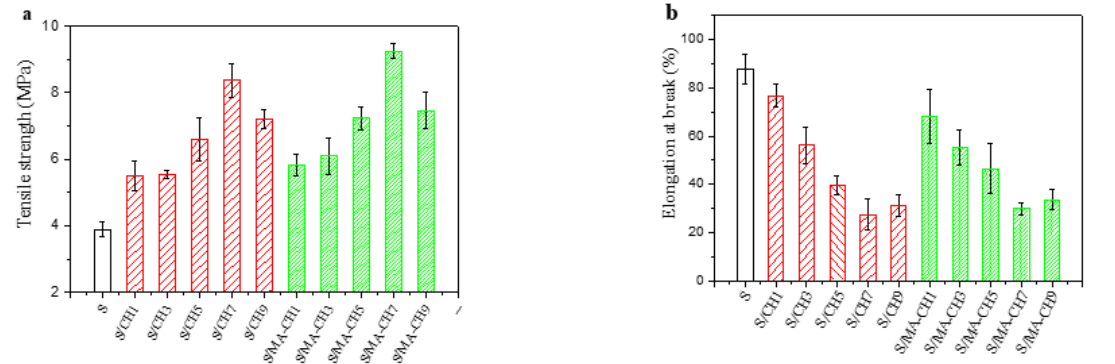
Figure 1. Tensile strength ( a ) and elongation at break ( b ) of S films, S / CH 1% films, S / CH 3% films, S / CH 5% films, S / CH 7% films, S / CH 9%, S / MA-CH 1% films, S / MA-CH 3% films, S / MA-CH 5% films, S / MA-CH 7% films, and S / MA-CH 9% films.